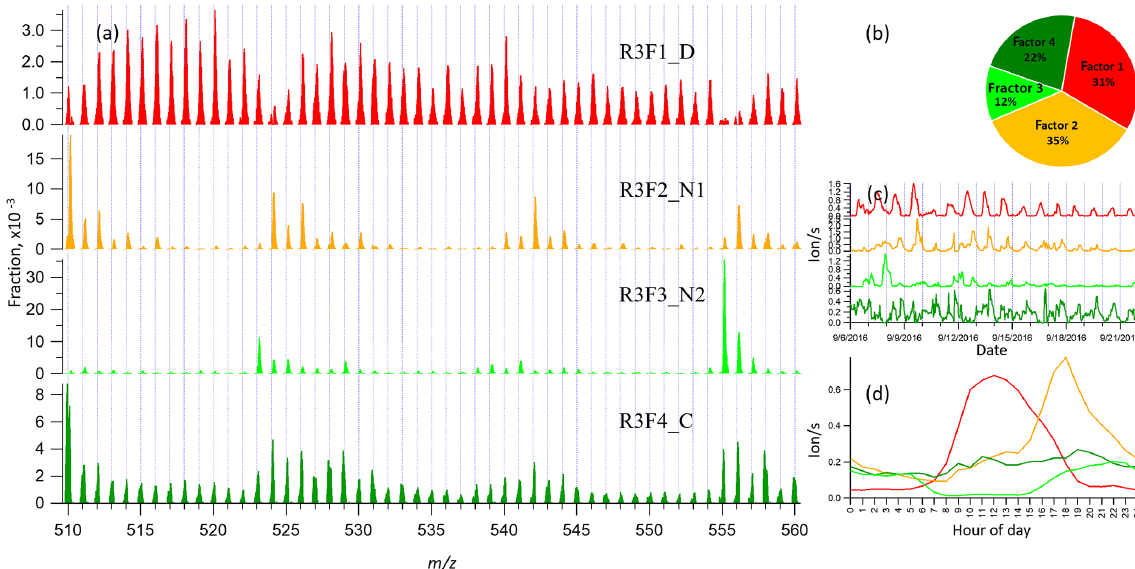
Figure 4. Four-factor result for Range 3 for (a) factor spectral profiles, (b) averaged factor contribution during the campaign, (c) time series, and (d) diurnal trend. Details on the naming schemes for the factors are shown in Table